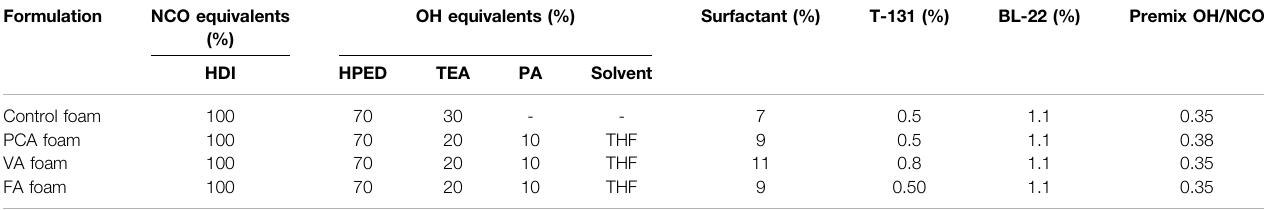
TABLE 1 | Synthesized PA-containing SMP foam compositions. NCO: isocyanate, OH: hydroxyl.